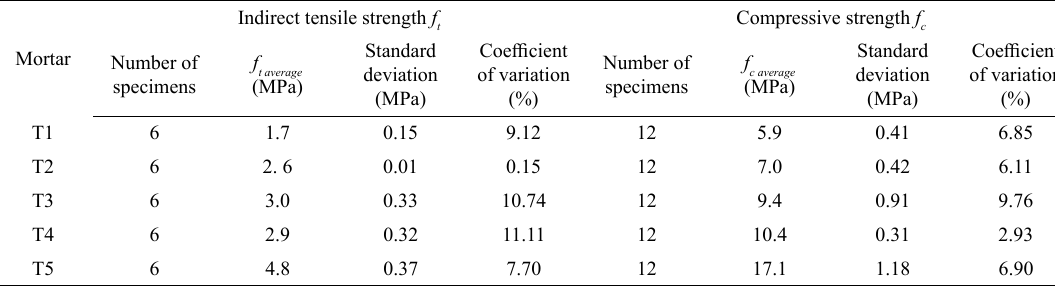
Figure 2. Determination of compressive strength and modulus of elasticity of cylindrical specimens. Table 5. Results of (4 x 4 x 16) cm prism specimens.